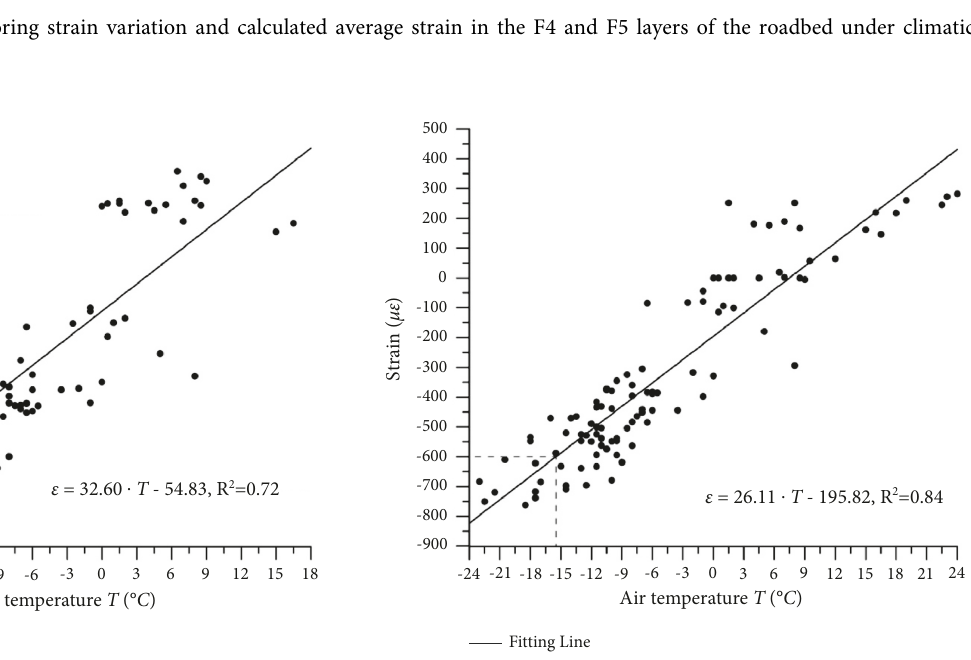
Figure 14: Relationship between the average strain of the F5 layer soil of the roadbed and the air